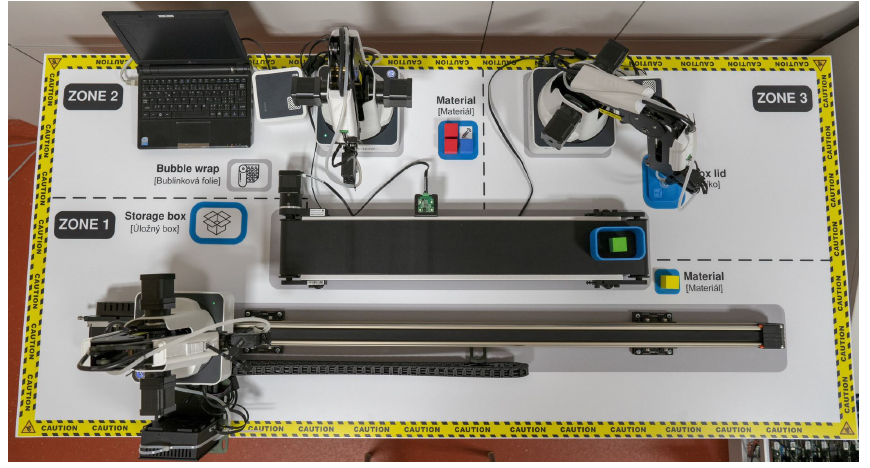
Figure 14. Industrial production loop.